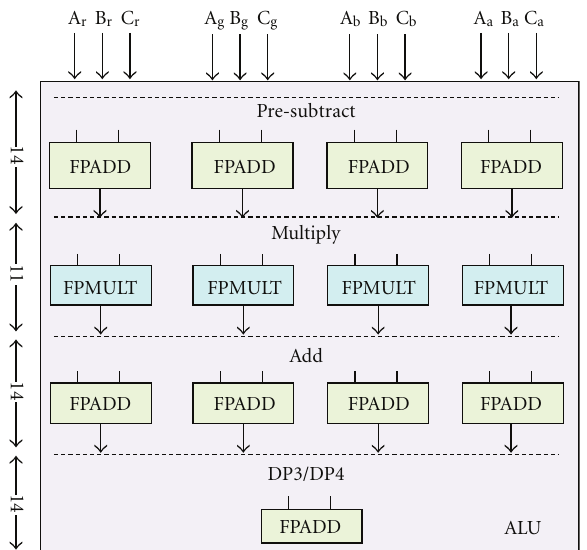
Figure 5: The floating point units in a datapath that supports MADD, DP3, and DP4 ALU instructions. The pipeline latency of each unit is shown on the left (for Altera floating point IP cores), and the total latency of the datapath is 53 cycles without accounting for extra pipeline stages for multiplexing between units.